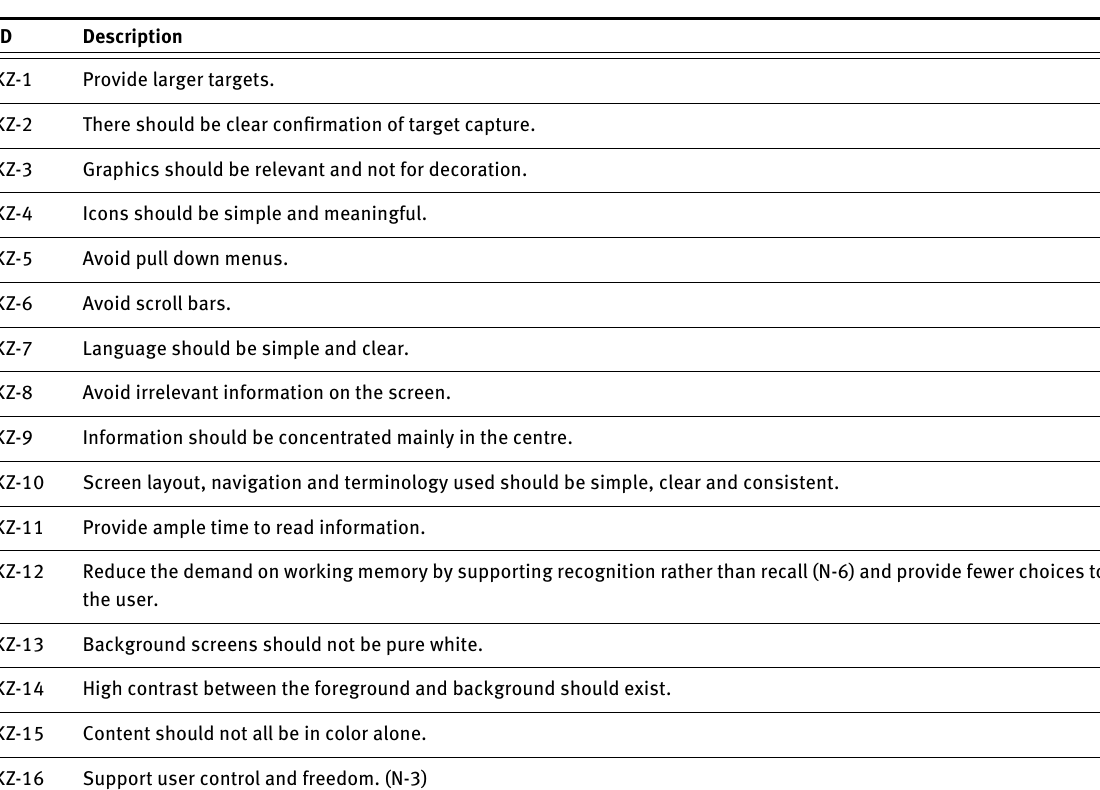
Table 11. Relevant Kurniawan and Zaphiris’s Web Design Guidelines for Older Adults [42] ID